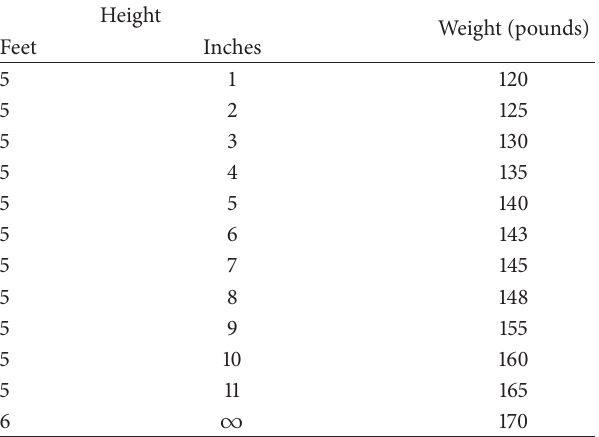
Table 1: Table of height and weight [17, page